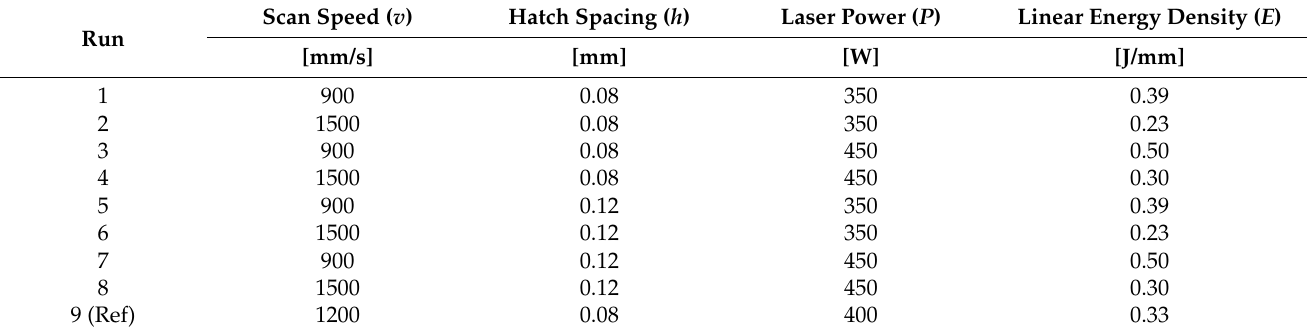
Table 1. Applied Design of Experiment.